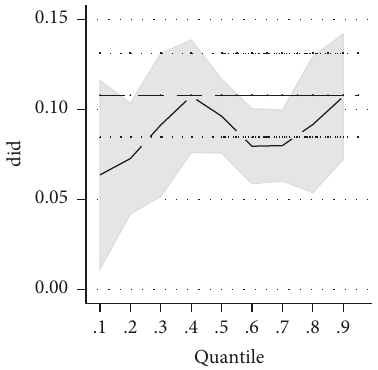
Figure 1: Quantile regression change trend chart.